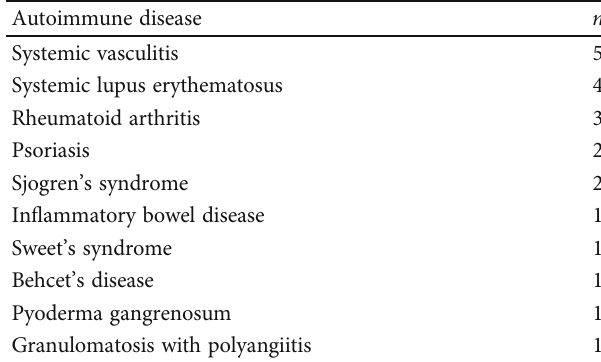
Table 2: Di ff erent types of MDS-associated autoimmune disease. Autoimmune disease